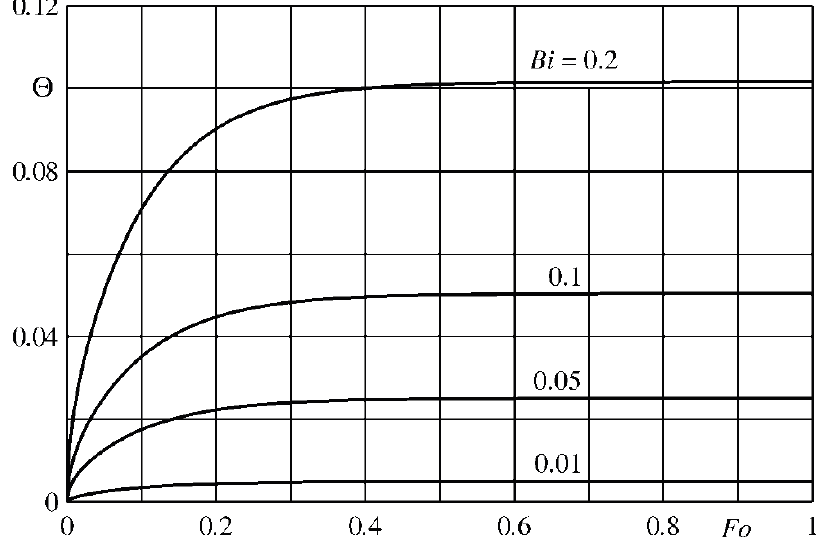
Figure 10. Θ as a function of Fo for several Bi values. Adapted from